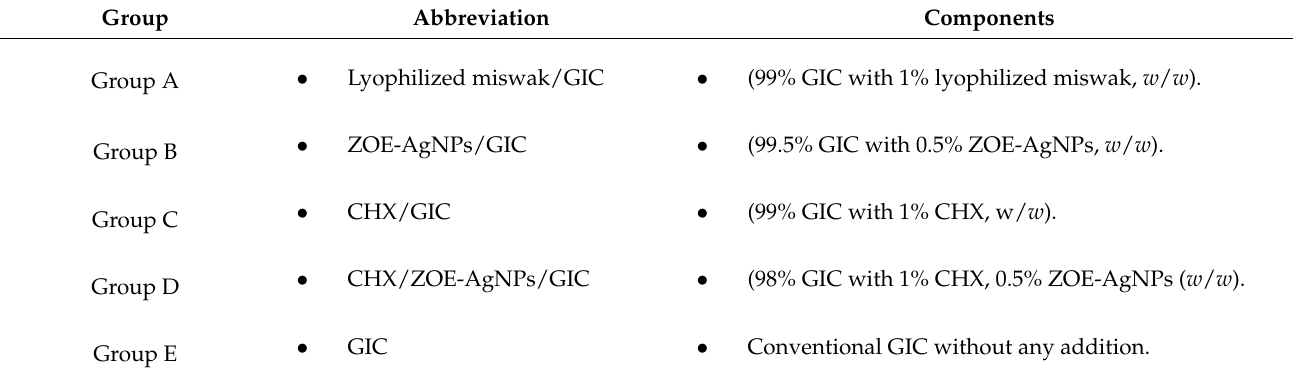
Table 4. Proportion of the Lyophilized miswak, ZOE-AgNPs and Chlorhexidine diacetate added to Conventional